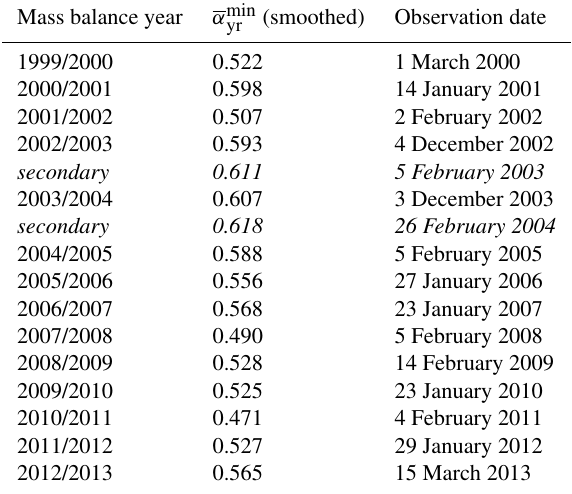
Table 2. Dates and minima of the annual glacier-wide albedo. The dates and values of the secondary minimum for mass balance years 2002/2003 and 2003/2004 are shown in